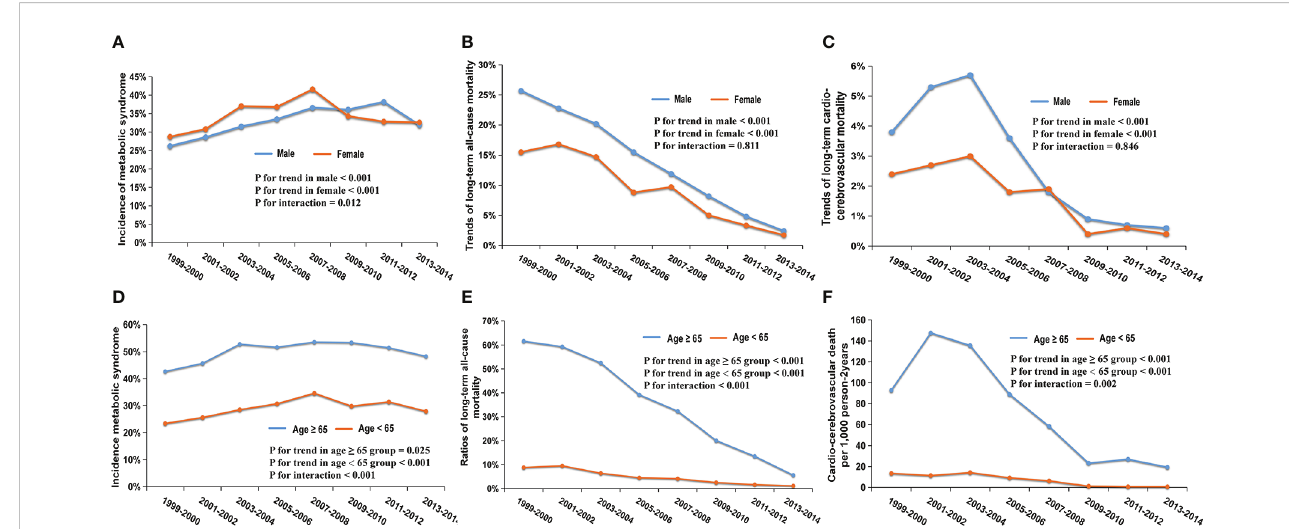
FIGURE 3 Trends in the incidence and mortality of different gender and age subgroups from 1999 to 2014; (A) Trends in the incidence of MetS among men (P for trend <0.001) and women (P for trend <0.001); (B) Trends of 7.7-year all-cause mortality among men (P for trend<0.001) and women (P for trend <0.001); (C) Trends of 7.7-year cardio-cerebrovascular mortality among men (P for trend<0.001) and women (P for trend <0.001); (D) Trends in the incidence of MetS among ≥ 65 years (P for trend=0.025) and <65 years (P for trend <0.001); (E) Trends of 7.7-year all-cause mortality among ≥ 65 years (P for trend<0.001) and <65 years (P for trend <0.001); (F) Trends of 7.7-year cardio-cerebrovascular mortality among ≥ 65 years (P for trend<0.001) and <65 years (P for trend <0.001).